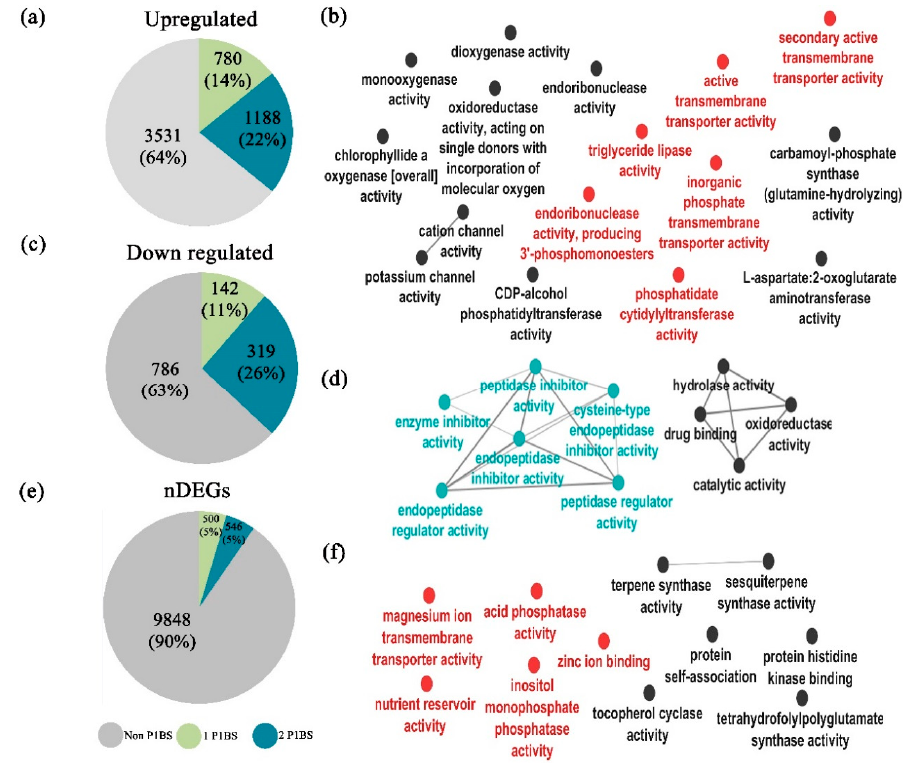
Figure 5. Genome-wide identification of PHR1 binding sites (P1BS) distribution on M. polymorpha . ( a ) Pie chart showing the number of promoter regions of up-regulated DEGs that lack the P1BS motif (in gray) and those whose promoter has one (green) or two (blue) motifs; the same color code applies for those pie charts y ( c ) and ( e ). ( b ) Illustrates the GO analysis of the up-regulated DEGs that contain the P1BS CREs; red color indicates the subcategories that are strongly associated to Pi starvation responses, and black indicates those terms that have no evident link to the Pi starvation responses (PSR). ( c ) Pie chart showing the number of promoter regions of down-regulated DEGs that lack the P1BS motif and those whose promoter has one or two motifs. ( d ) The GO network for the down-regulated genes with P1BS motifs, blue nodes indicate subcategories that have been related to PHR1 function in regulating genes involved in other stress conditions described in A. thaliana [71], dark nodes show categories with no evident link to the Pi starvation response. ( e ) Pie chart showing the number of promoter regions of non-DEGs that lack the P1BS motif and those whose promoter has one or two motifs. ( f ) The GO networks found after analysis of the genes with P1BS motives in the nDEGs group; subcategories related to low Pi availability appear in red, whereas black indicates the subcategories non-associated to the Pi limitation response. 3. Discussion 3.1. Morpho-Physiological Responses upon Pi Starvation In the present work, the morphological and physiological responses of the rootless plant M. polymorpha to low Pi availability were described. Among these responses, we found an increase in the size and number of rhizoids under low Pi conditions (Figure 6). In A. thaliana , the increase in root hair density during Pi deprivation has been described as a strategy to improve the assimilation zone in the rhizosphere [51]. Hence, the modulation of rhizoid development under limited conditions of Pi could be involved in enhancing Pi uptake. It has been shown in M. polymorpha that rhizoid development is regulated by auxin signaling and metabolism [73–76]. We also found that a biomass